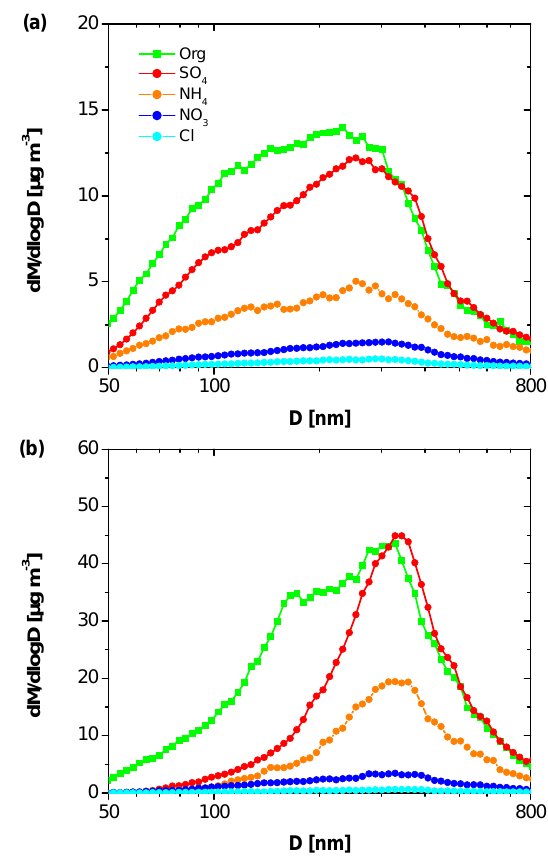
Fig. 1. Mass size distributions of organic and inorganic compounds determined by aerosol mass spectrometry (AMS) averaged (a) over the campaign excluding the biomass burning event (BBE), and (b) over the BBE plotted against the mobility equivalent particle